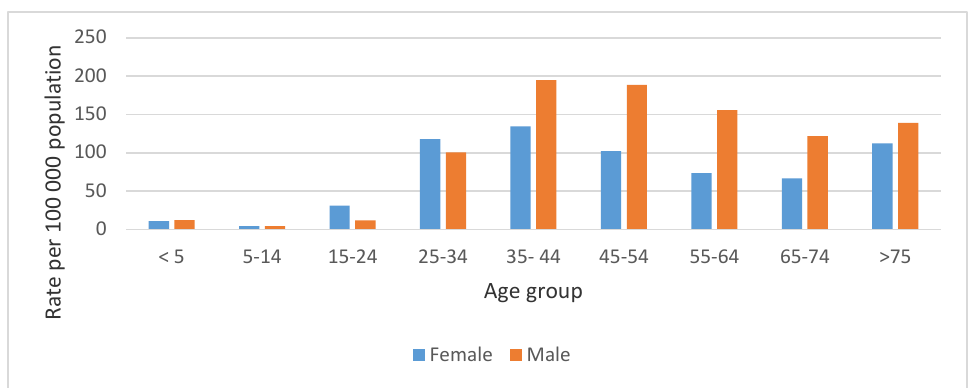
Figure 1: Tuberculosis mean Annual Death Rate per 100 000 Population by Gender and Age Group in South Africa, 2005-2015